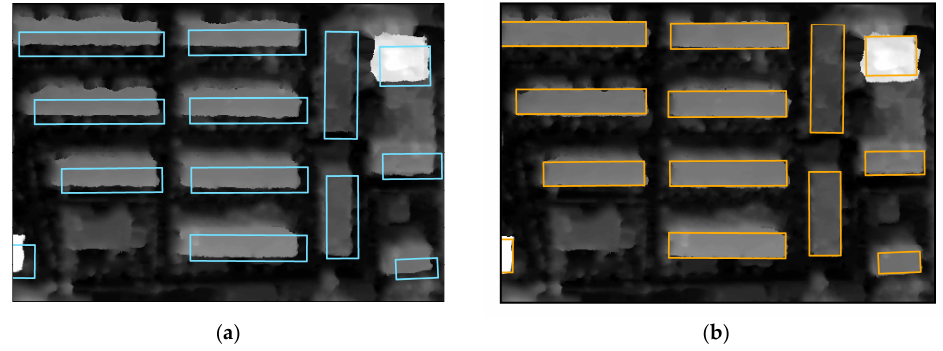
Figure 3. The effect of the coarse registration. The blue polygons in ( a ) are the original OSM and the orange polygons in ( b ) are the translated OSM after the coarse registration.